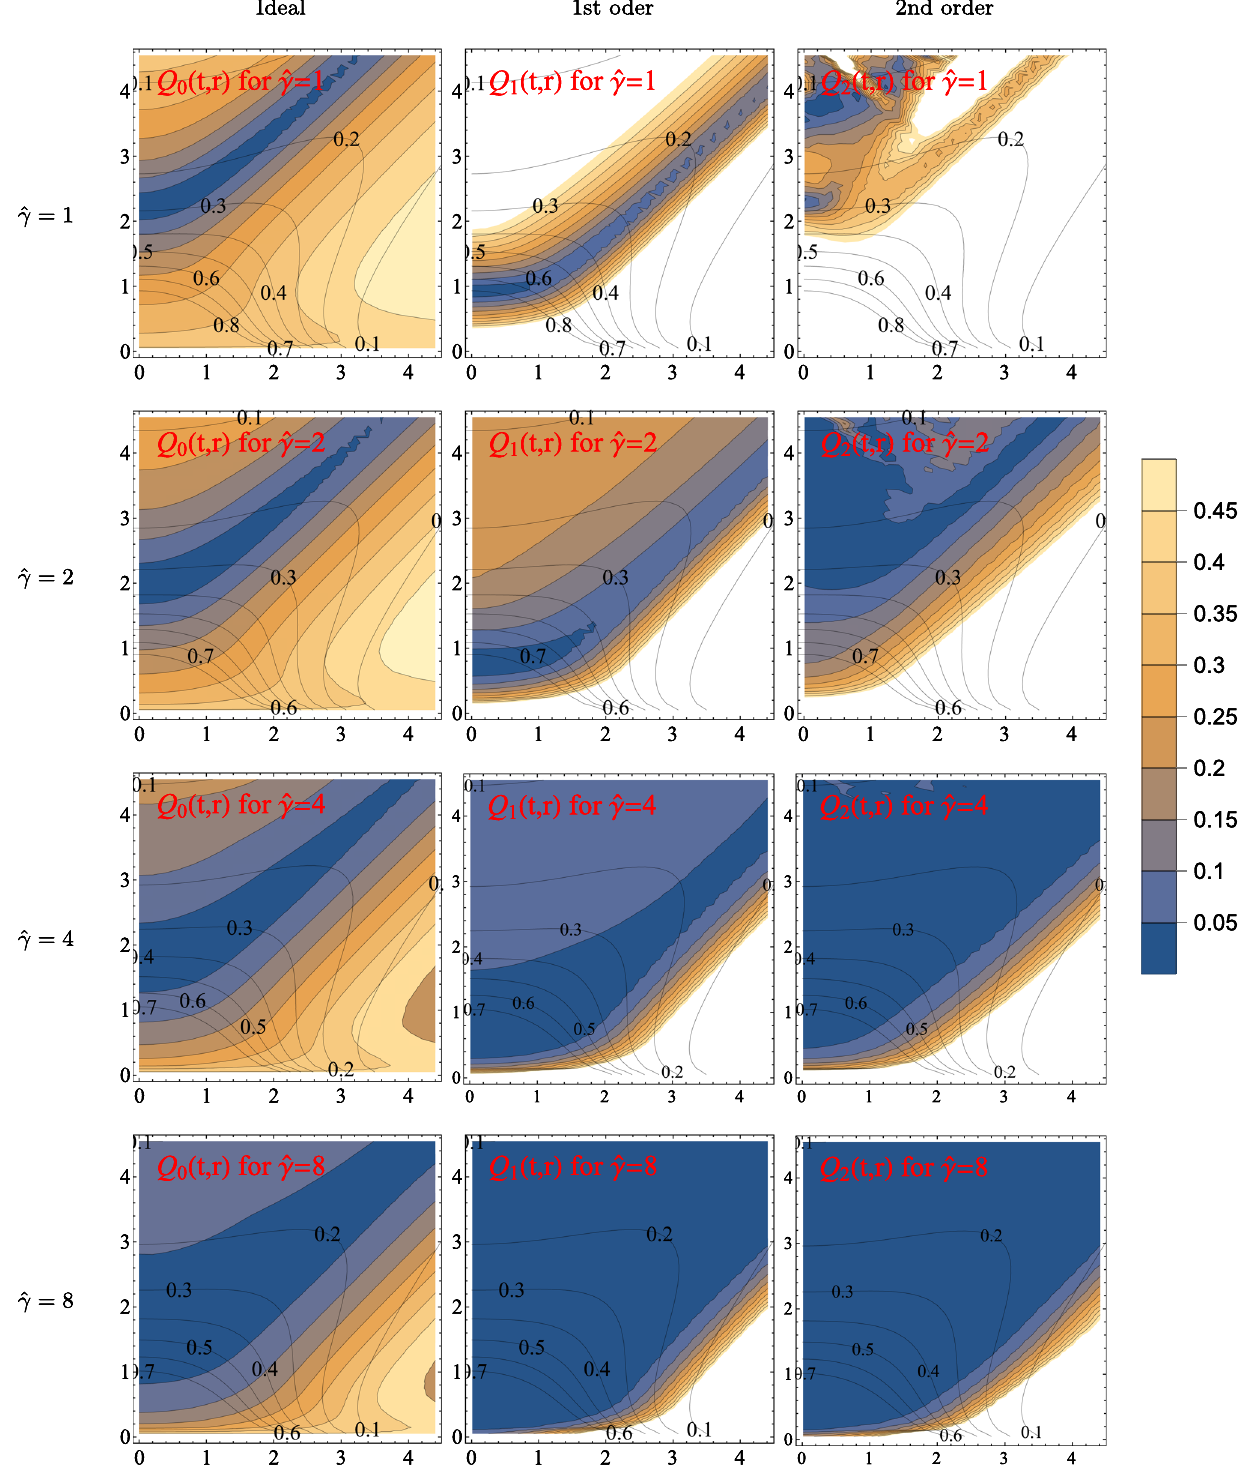
Fig. 3 The difference between the energy-momentum tensor T μν cal- μν culated in kinetic theory, and T defined via the constitutive hydro- hyd dynamic Eqs. (13)–(16), plotted in the ( r , t ) -plane in units of the local energy density ε( t , r ) . White regions indicate Q i > 0 . 5 for i = 0 , 1 , 2.